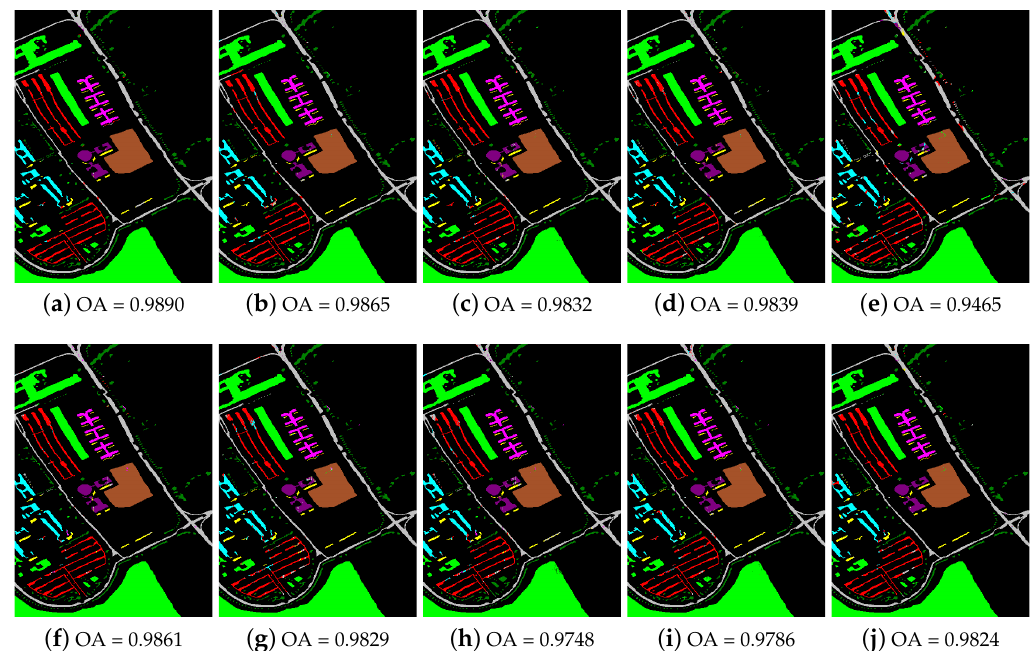
Figure 7. Supervised and semi-supervised classification results (Pavia University scene) obtained by: